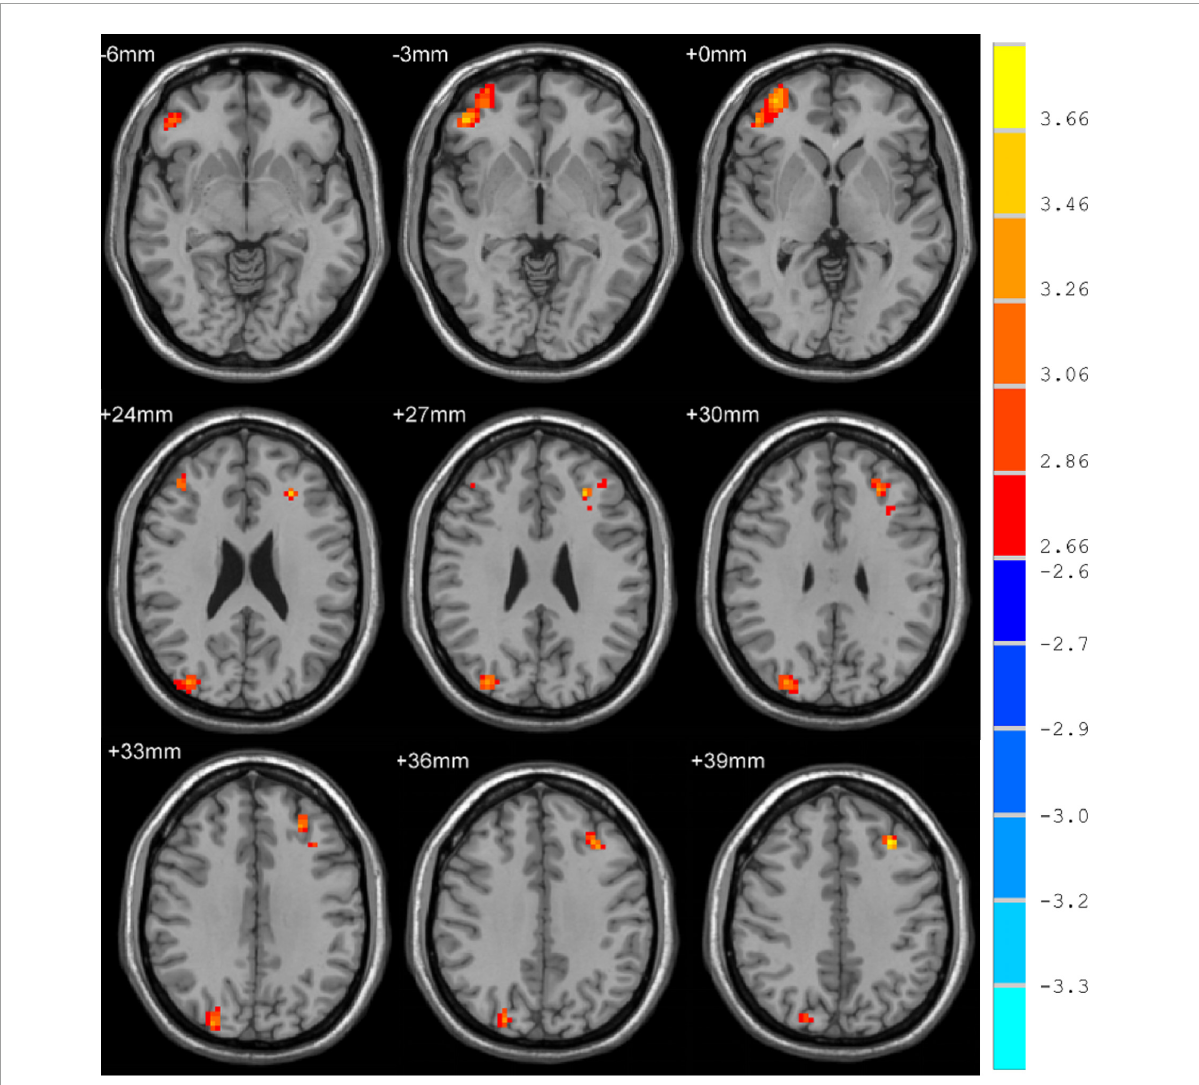
FIGURE1 Brain regions where fALFF levels are significantly different in MDD patients to that of healthy